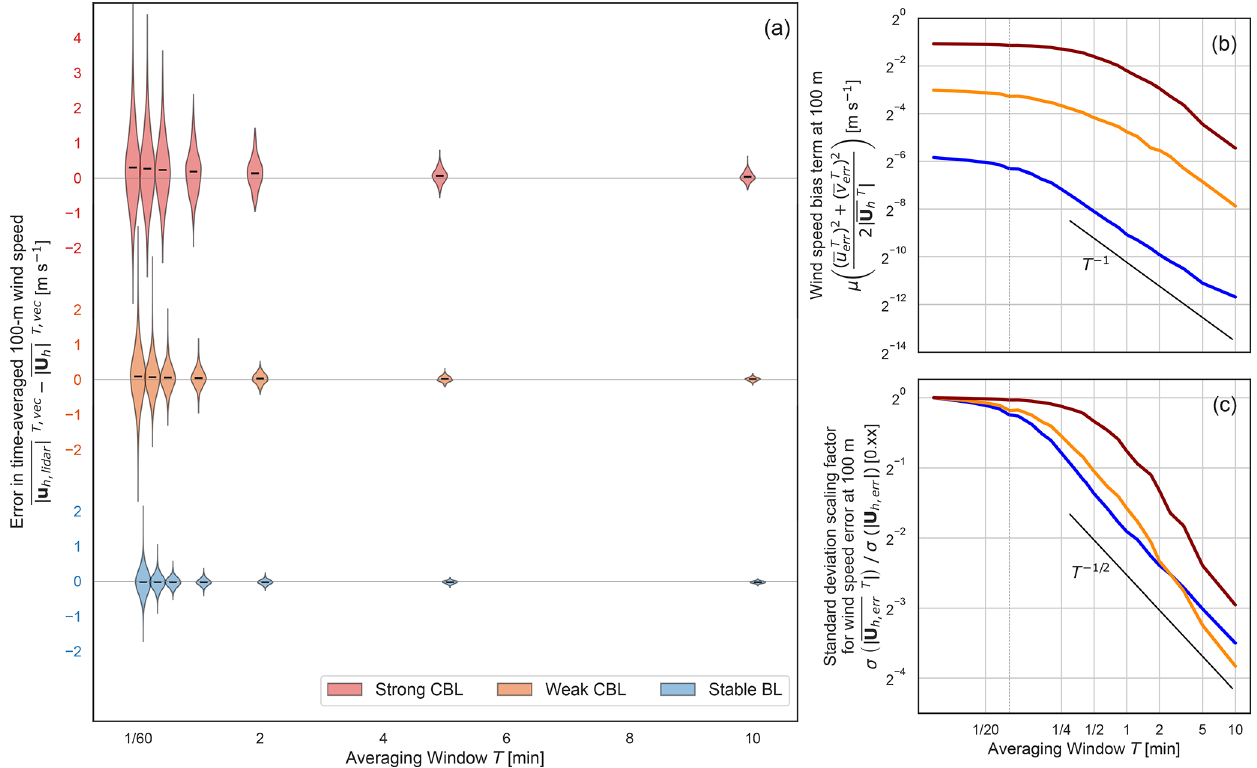
Figure 15. Wind speed error at 100m under a vector time average. (a) A violin plot of the error distribution and mean for each stability over several averaging windows up to 10min. (b) The reduction in the second-order positive bias term against a reference T − 1 rate. (c) The reduction in the error standard deviation against a reference T − 1 / 2